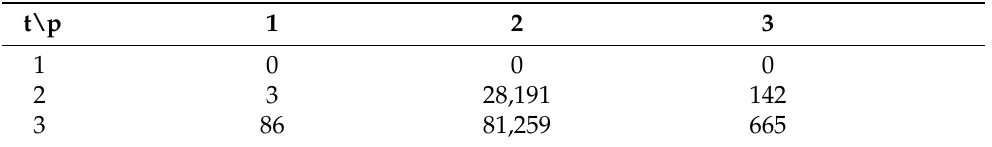
Table 13. The confusion matrix for TUG of participant 19. The model is not able to distinguish between score 3 and score 2 for this participant. t = true label, p = predicted